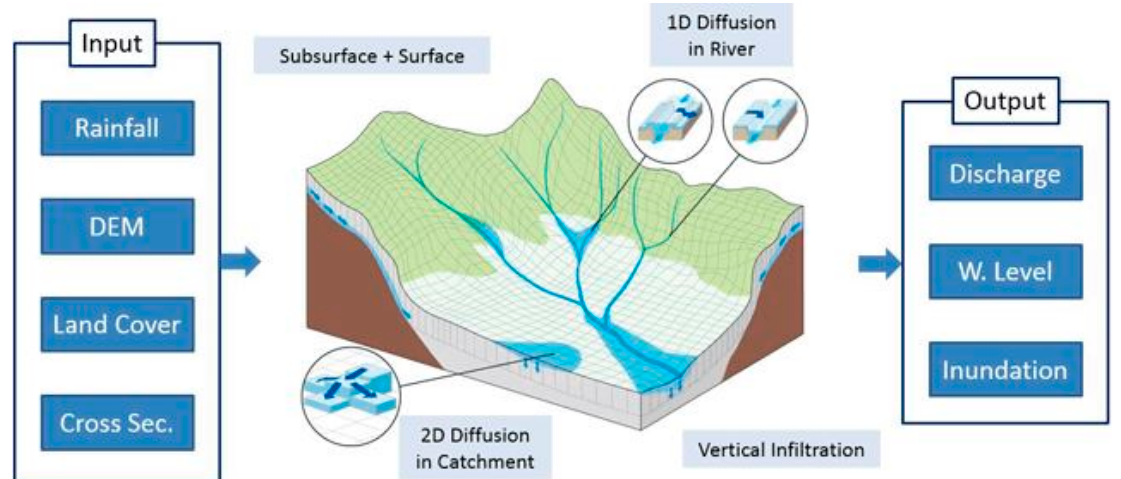
Figure 3. Schematic diagram of Rainfall-Runoff-Inundation (RRI) Model.